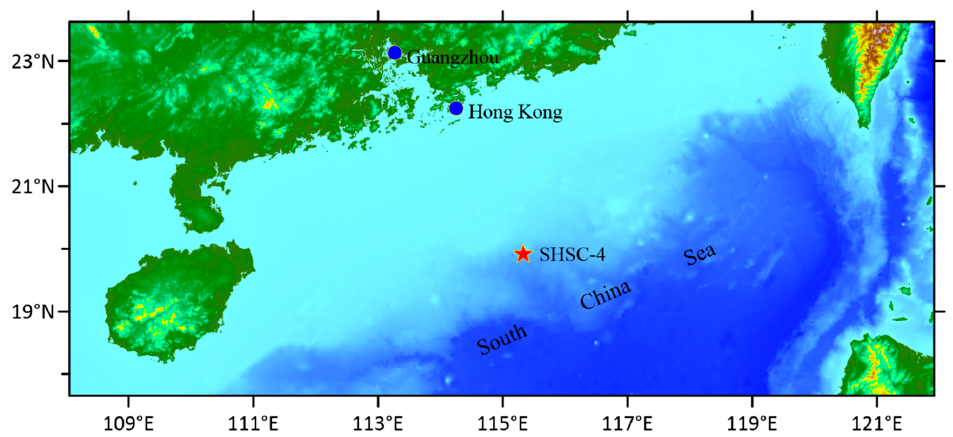
Figure 1. Location of China’s first offshore gas hydrate production test in the South China Sea (SCS). The production test site named SHSC-4 (red solid star), which water depth is about 1263.5 m.